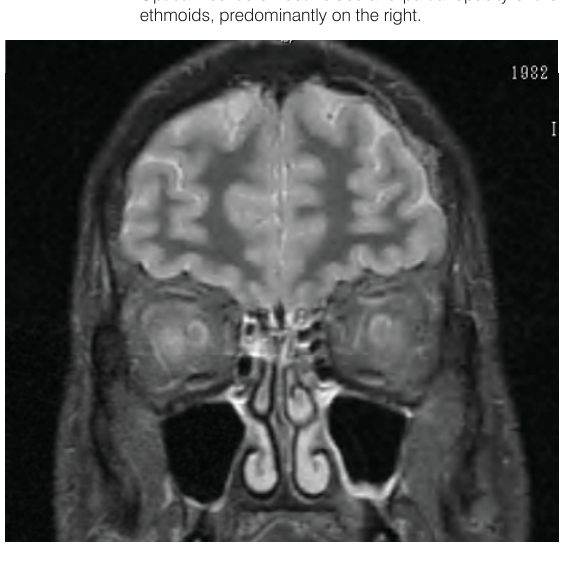
Figure 1. Axial CT scan of paranasal sinuses and orbits: Bilateral opacity of the paranasal sinuses and mucocele of the sphenoid sinus and posterior ethmoids on the right.